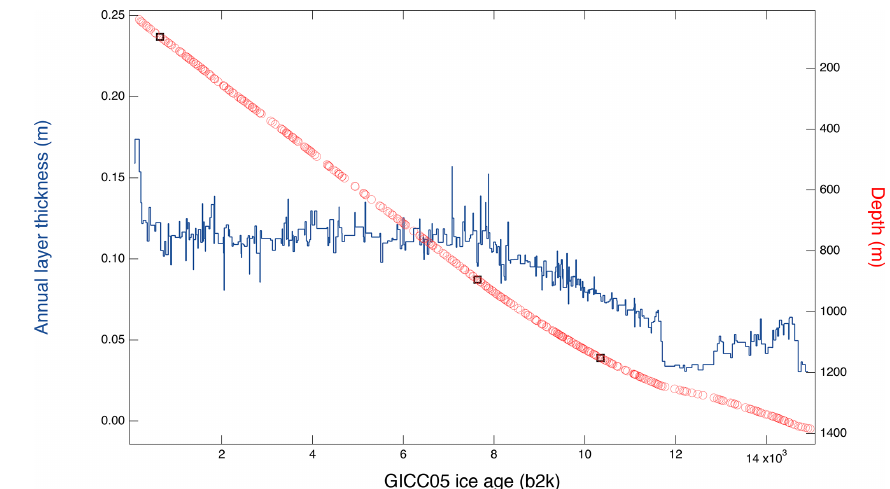
Figure 9. Average EGRIP annual layer thicknesses (dark blue line, left y axis) between the match points. The EGRIP depth–age relationship (right y axis) with match points (red dots) and the tephra horizons (black squares).